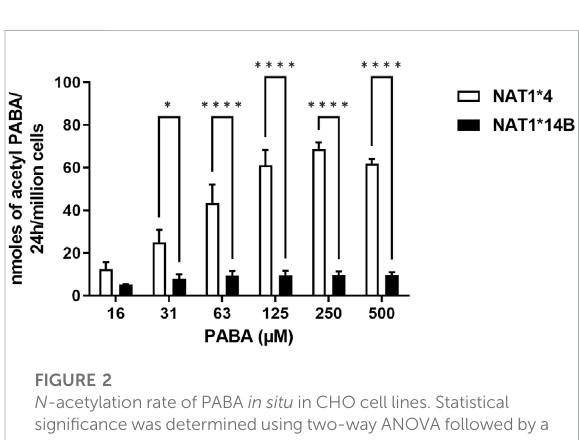
FIGURE 2 N -acetylation rate of PABA in situ in CHO cell lines. Statistical signi fi cance was determined using two-way ANOVA followed by a Bonferroni ’ s post-hoc test. Data illustrates mean ± SEM of three independent experiments (* p < 0.05, **** p <